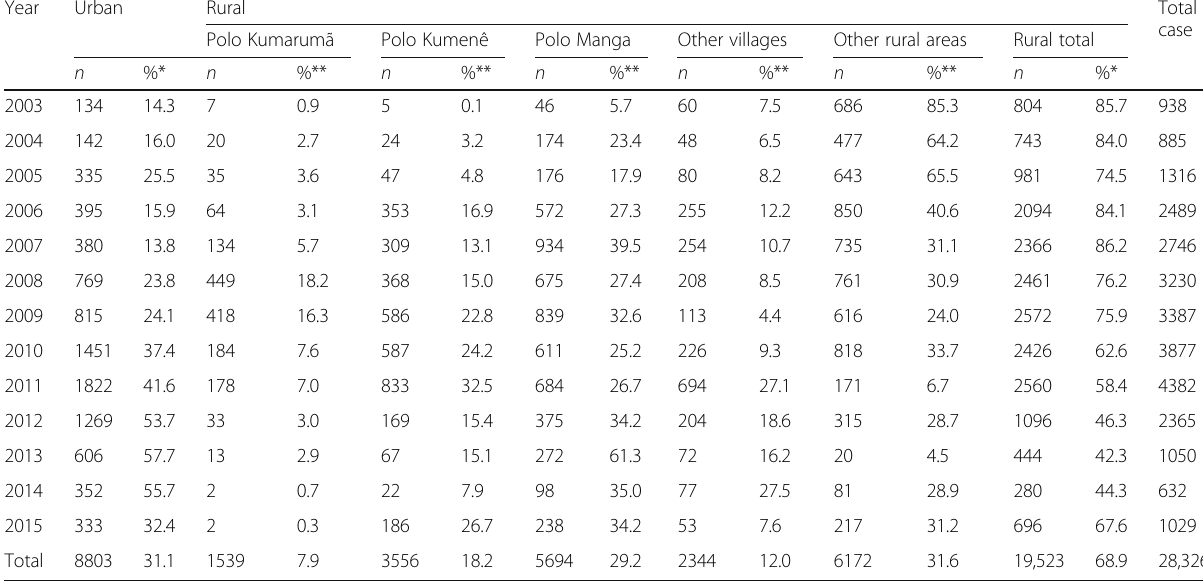
Table 1 Cases of malaria reported in the municipality of Oiapoque, Amapá, Brazil, according to geographical area of origin, 2003 – 2015